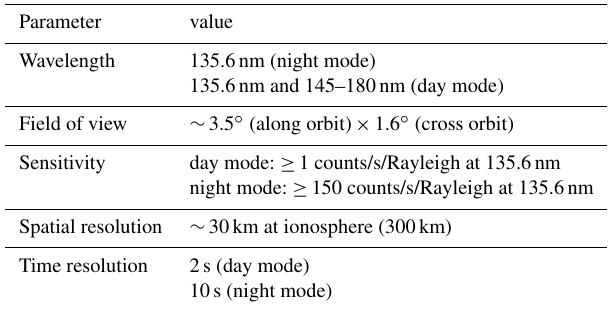
Table 1. FY3D IPM instrument